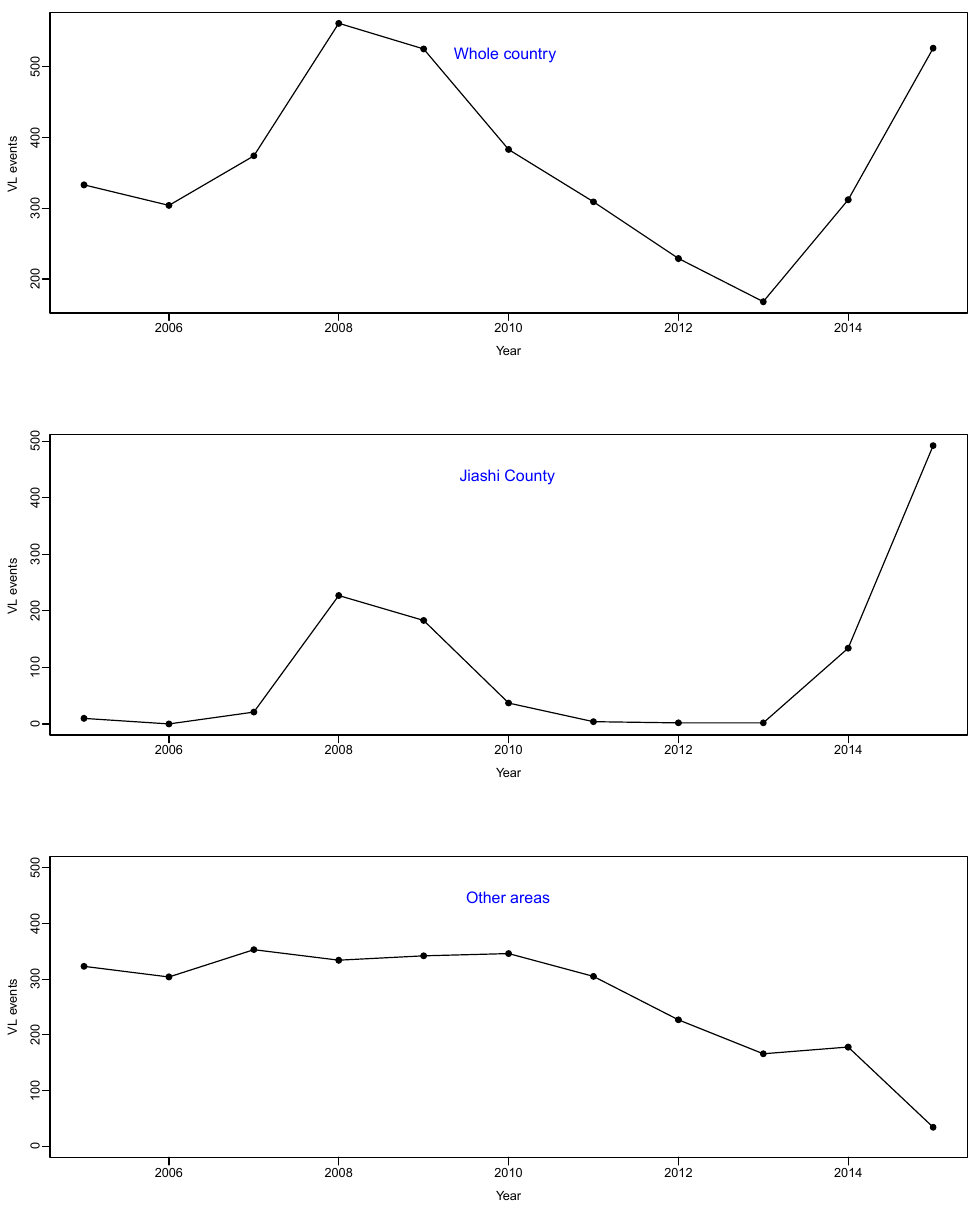
Figure A1. VL cases reported in the whole country and Jiashi County during 2005–2015.